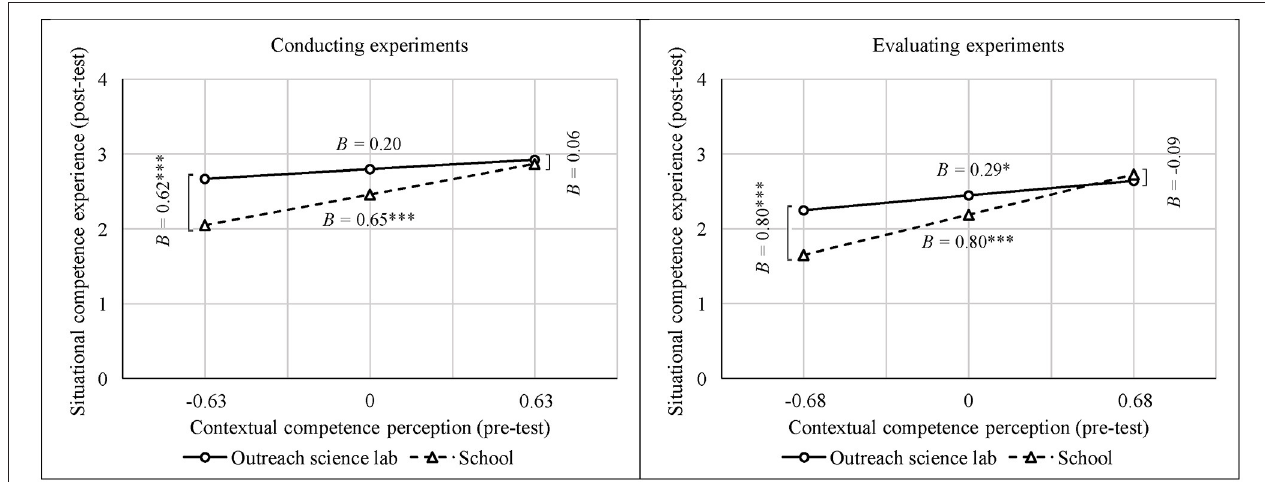
FIGURE 3 | Students’ situational competence experiences (post-test) while conducting (left) and evaluating experiments (right) depending on their contextual competence perceptions (pre-test) in conducting and evaluating experiments in the treatments outreach science lab and school ( * p < 0.05, *** p < 0.001).